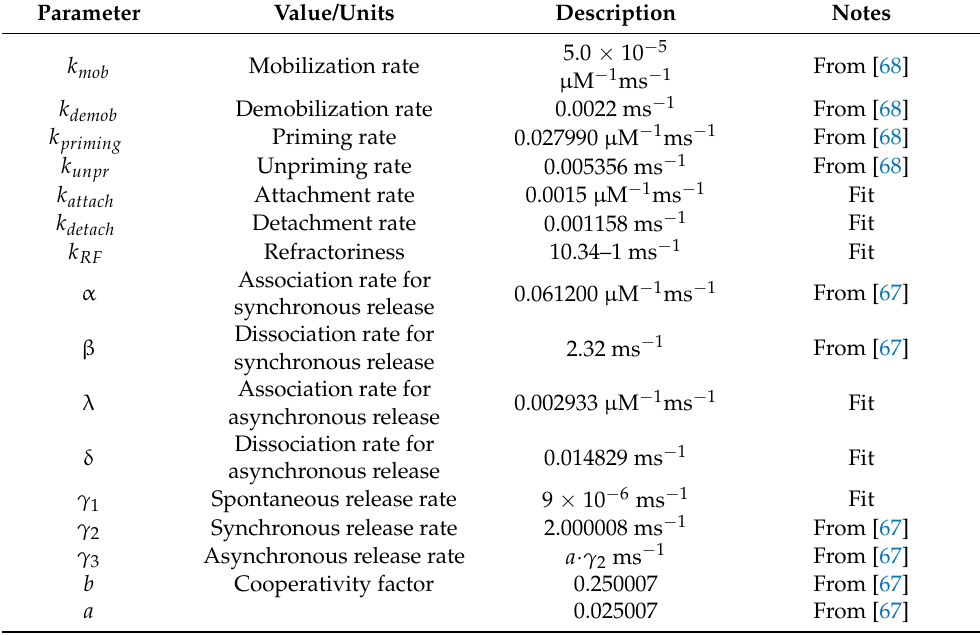
Table 10. Reaction rates for kinetic schemes for